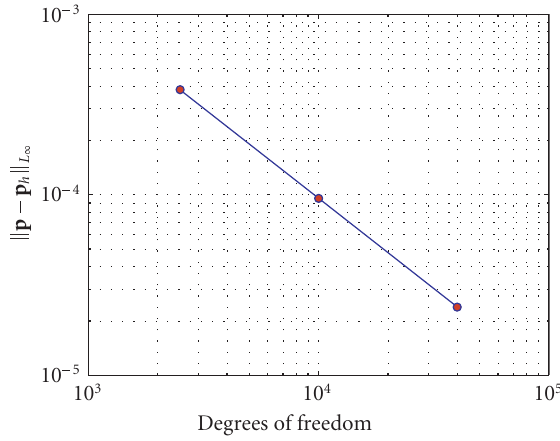
Figure 4.8 . Example 4.2: convergence of the discretization scheme. L ∞ error versus the degrees of freedom in the mesh. We are observing (cid:4) p − p h (cid:4) L